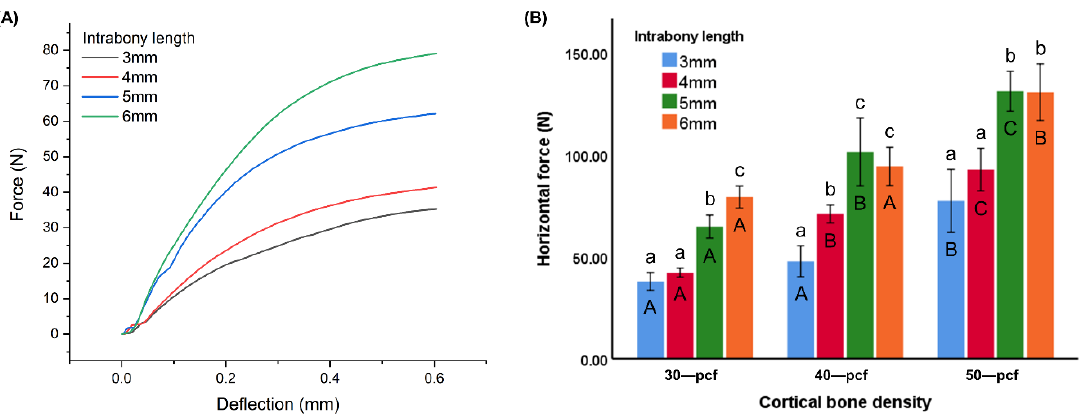
Figure 8. Horizontal resistance represented as ( A ) horizontal force versus deflection distance and ( B ) horizontal force values at 0.6 mm deflection. Di ff erent uppercase letters indicate a significant di ff erence between the miniscrews inserted into cortical bone of various densities ( p < 0.05), while di ff erent lowercase letters indicate a significant di ff erence between the miniscrews at the various intrabony lengths ( p < 0.05).